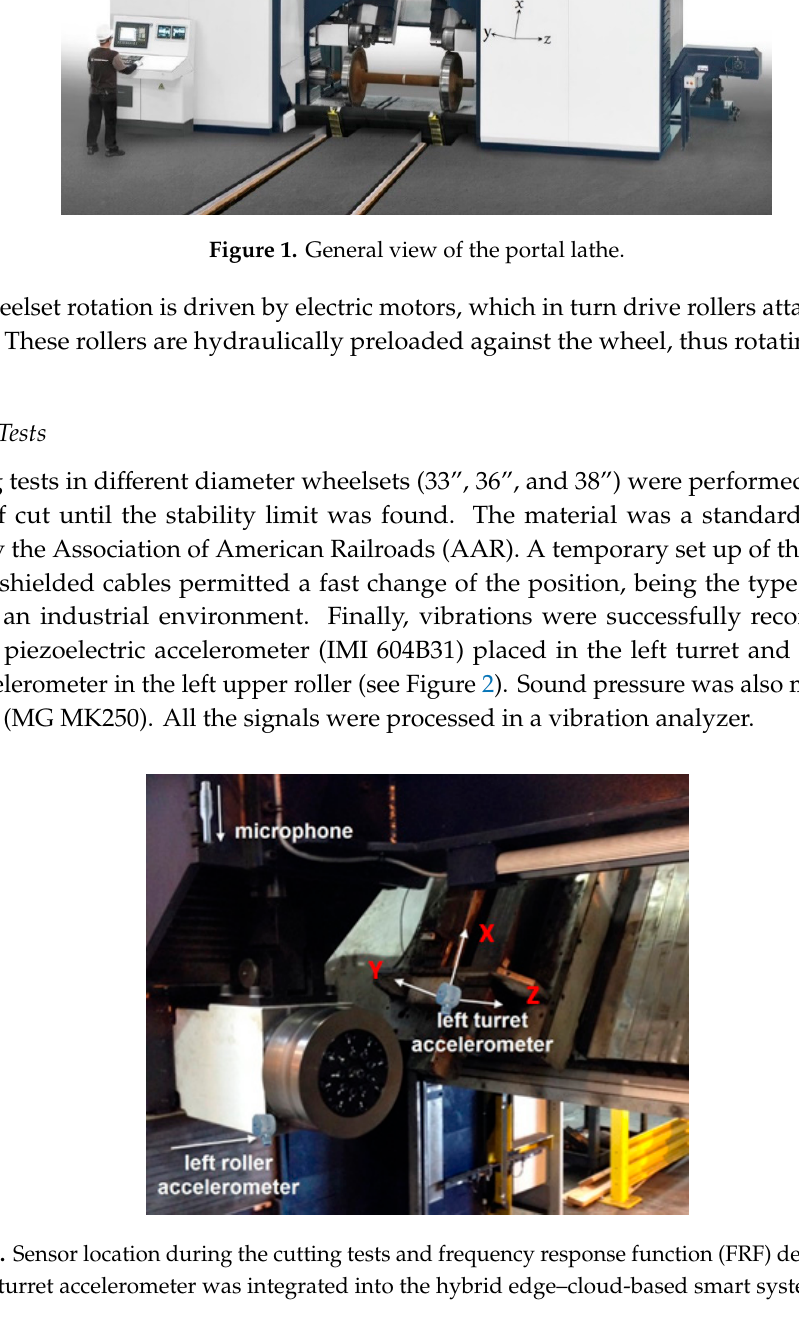
Figure 1. General view of the portal lathe.